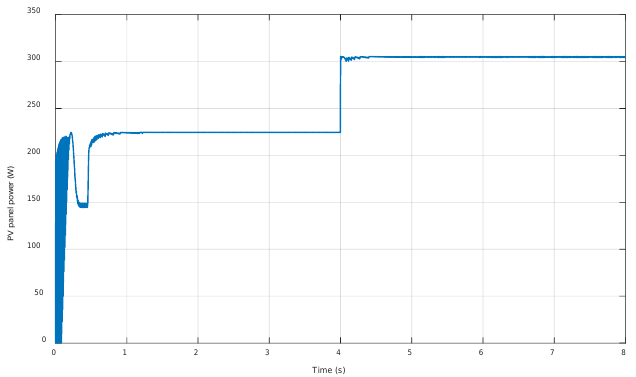
Figure 10. The variation of irradiance.